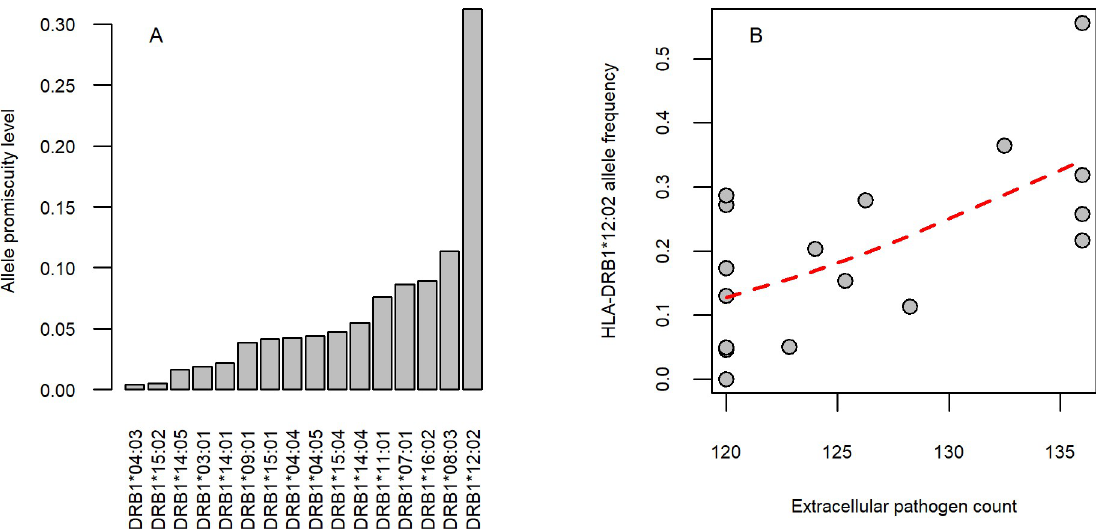
Fig 2. HLA-DRB1 � 12:02 allele promiscuity level and extracellular pathogen diversity in Southeast Asia. (A) HLA-DRB1 � 12:02 has an exceptionally high promiscuity level compared with other alleles. The figure shows alleles with at least 10% frequency in at least one population in Southeast Asia. Predicted allele promiscuity values are shown. (B) The mean frequency of DRB1 � 12:02 increases with extracellular pathogen diversity across population groups (Spearman’s rho: 0.57, P = 0.017). Populations that resided in China, Japan, South Korea, Indonesia, Malaysia, and the Philippines were included in the analysis. Red curve indicates smooth curve fitted using cubic smoothing spline method in R (see Methods). The underlying data for this figure can be found in S4 Data.